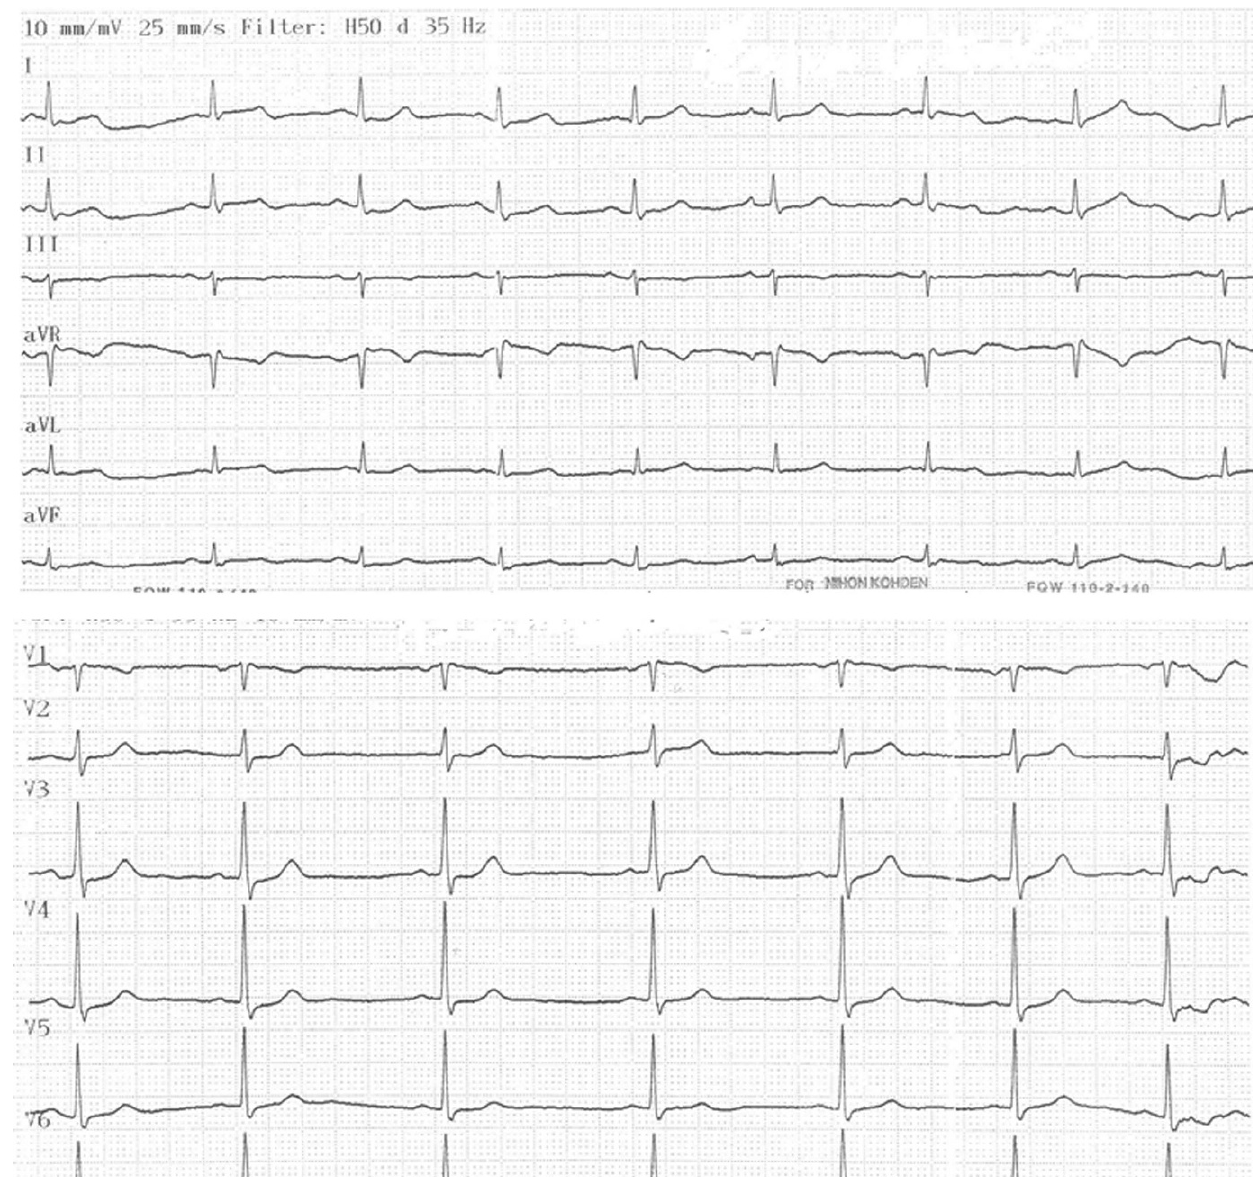
Figure 2 - Normal sinus rhythm 6 hours